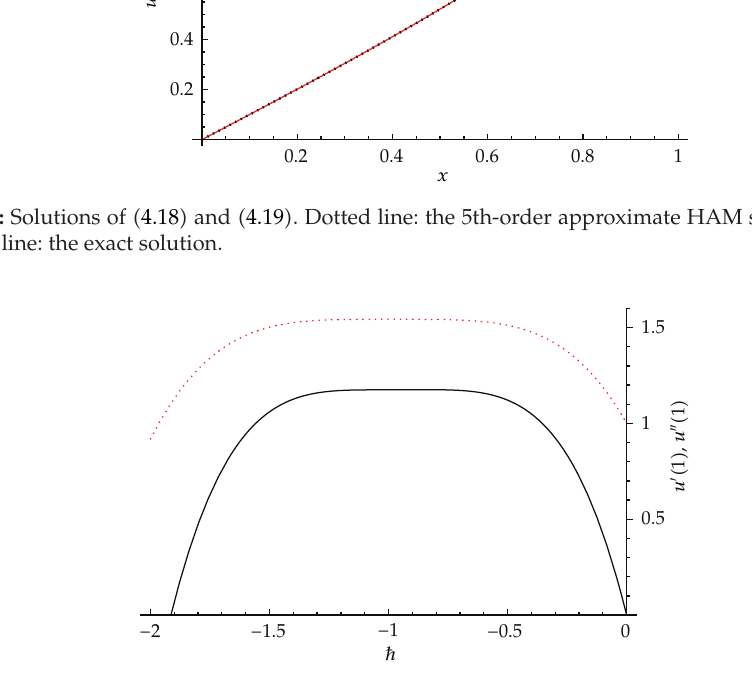
Figure 13: The (cid:2) -curves of u (cid:2) (cid:4) 1 (cid:5) and u (cid:2)(cid:2) (cid:4) 1 (cid:5) which are corresponding to the 5th-order approximate HAM solution of (cid:4) 4.18 (cid:5) and (cid:4) 4.19 (cid:5) . Dotted line: u (cid:2) (cid:4) 1 (cid:5) and solid line: u (cid:2)(cid:2) (cid:4) 1 (cid:5)